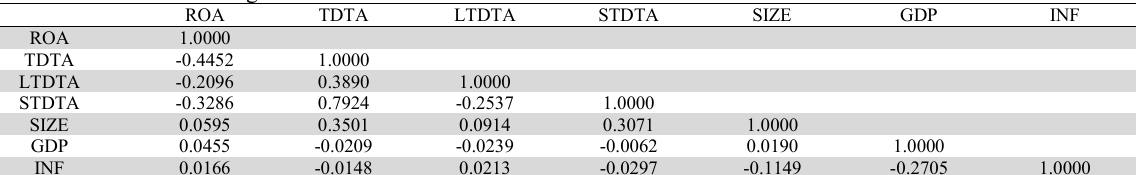
Correlation coefficients among variables